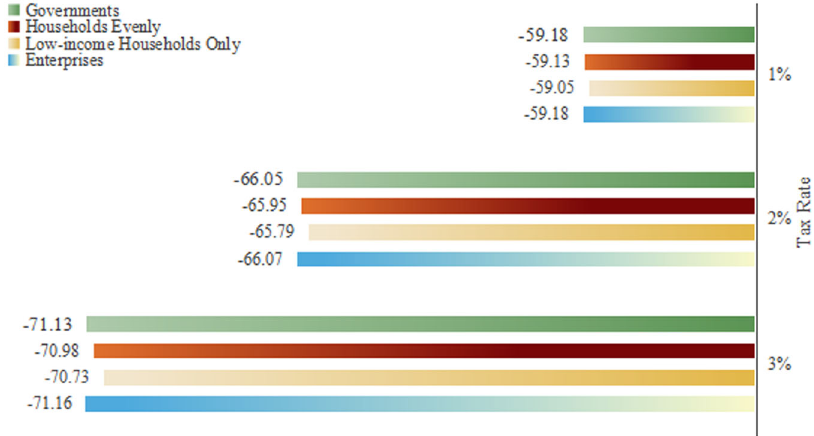
Fig. 6 Impacts of tax revenue recycling on relative utility (unit: 10 9 CNY). Shows impacts of tax revenue recycling on relative utility: the legends “ Governments ” , “ Households Evenly ” , “ Low-income Households Only ” , and “ Enterprises ” refer to revenue recipients are governments, entire households, low-income households, and enterprises.